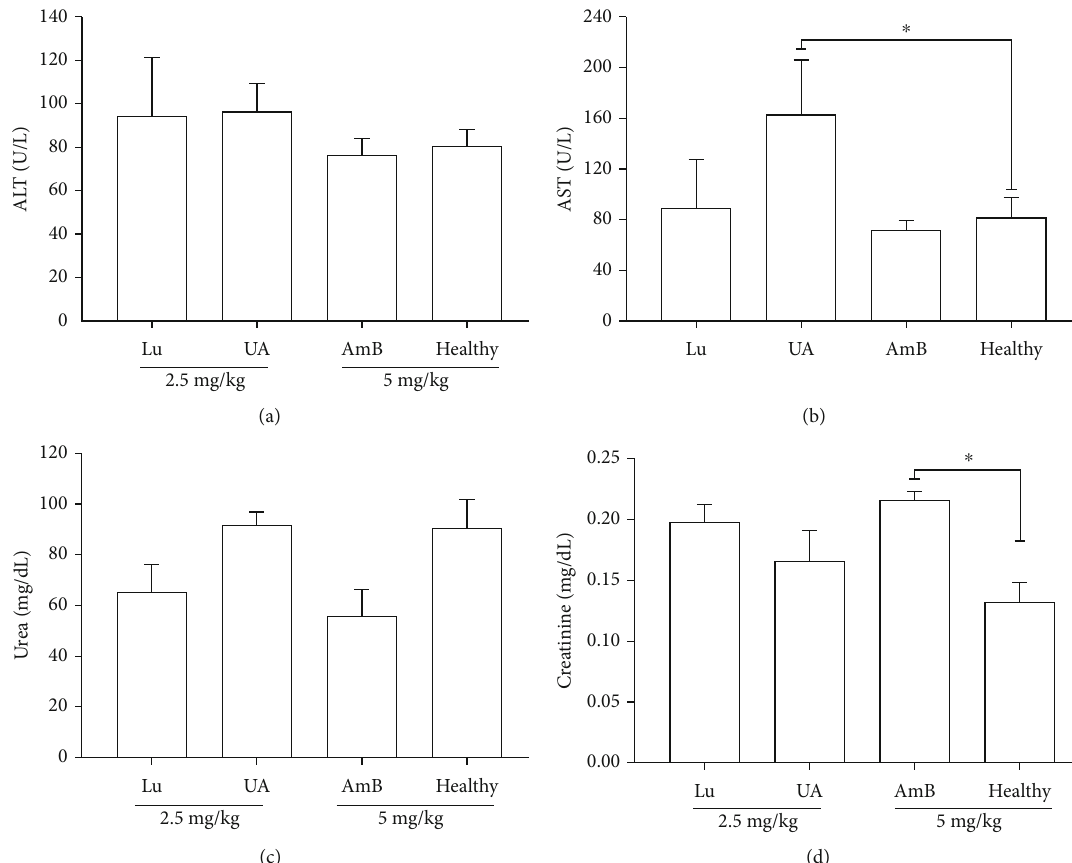
Figure 7: Blood biochemical parameters of hamster treated with lupeol (Lu), ursolic acid (UA), and amphotericin B (AmB). Levels of ALT (a), AST (b), urea (c), and creatinine (d) were quanti fi ed in the serum of animals treated with 2.5mg/kg of lupeol (Lu), ursolic acid (UA), or 5mg/kg of amphotericin B (AmB) during 10 consecutive days by intraperitoneal route. ∗ p < 0 : 05 indicates statistical signi fi